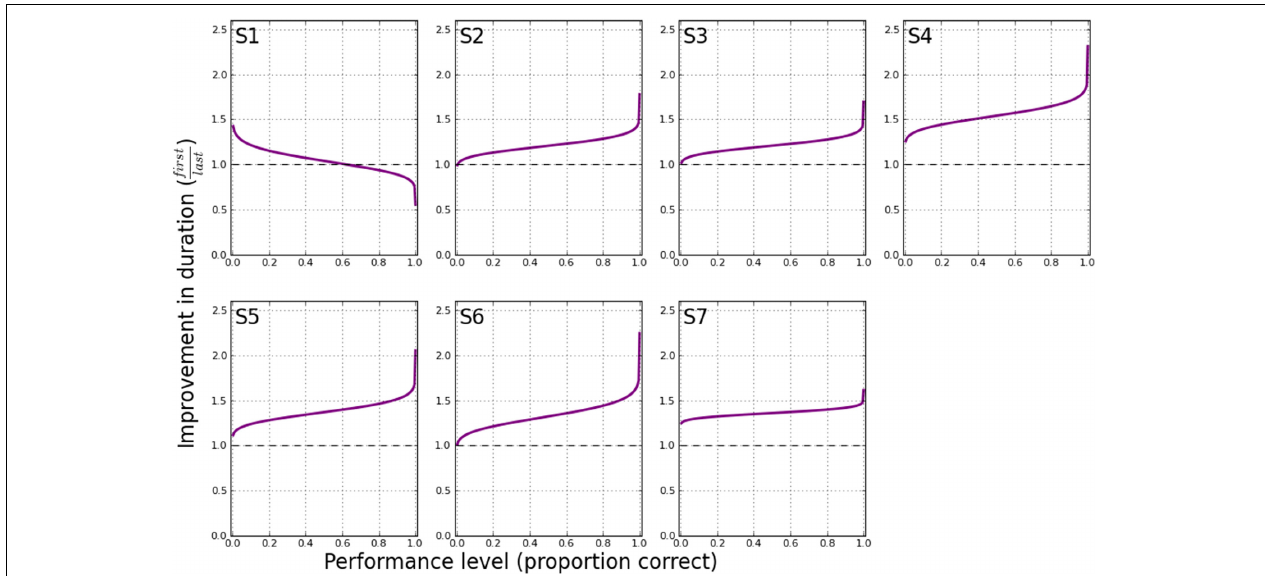
are determined that yield the specified performance. The ratio of these durations (first/last) is then plotted on the ordinate, at the performance level indicated by the